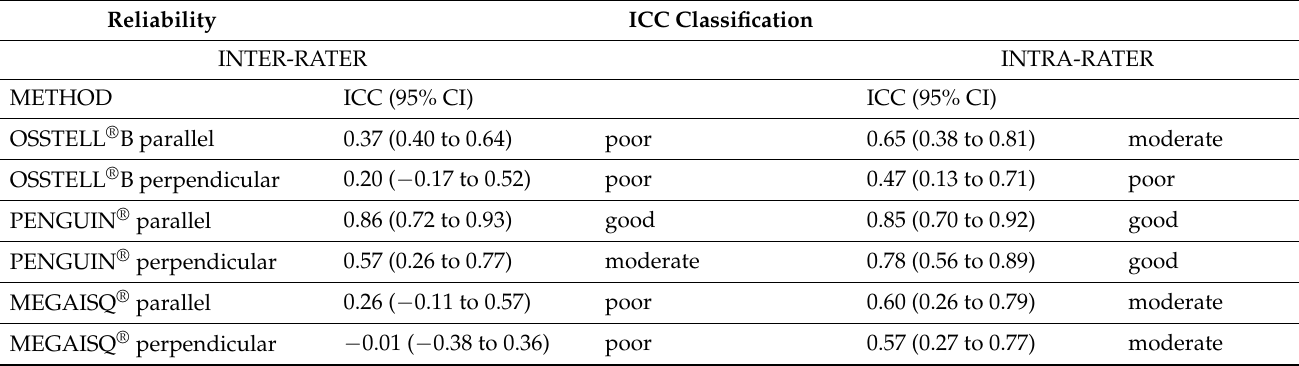
Table 2. Reliability (ICC; 95% CI) of the three devices used to measure ISQ.